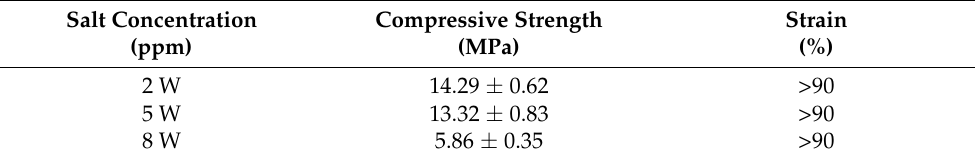
Figure 10. Effect of salt concentration on compressive stress of p–DN hydrogel. Table 2. Salt tolerance of p–DN